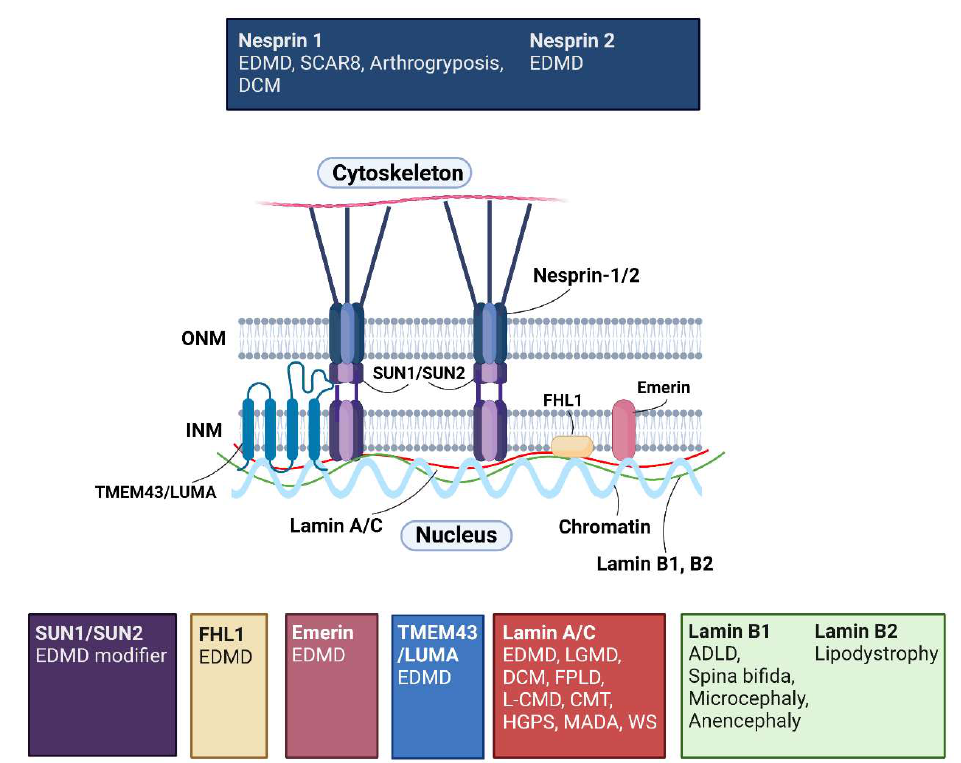
Figure 1. The Linker of Nucleoskeleton and Cytoskeleton (LINC) complex and associated human diseases. The Linker of Nucleoskeleton and Cytoskeleton (LINC) complex primarily consists of SUN1/SUN2 and nesprin proteins, that are located at the inner nuclear membrane (INM) and outer nuclear membrane (ONM), respectively. The respective proteins interact via their Sad1-UNC-84 and Klarsicht/Anc-1/Syne homology (KASH) domains in the lumen of the NE, creating a physical connection between the nuclear lamina (NL) and the cytoskeleton. The NL comprises of type-V intermediate filament proteins, the nuclear lamins. Lamins A/C are A-type nuclear lamins, whilst lamin B1/B2 are B-type lamins. Various other NE proteins interact with the LINC complex including integral INM protein emerin, TMEM43/LUMA and isoforms of four-and-a-half LIM domain protein 1 (FHL1). Mutations in the genes encoding these proteins have been associated with a range of diseases exhibiting different phenotypes. Abbreviations: Emery-Dreifuss muscular dystrophy (EDMD), cerebellar ataxia (SCAR8), dilated cardiomyopathy (DCM), limb-girdle muscular dystrophy (LGMD), familial partial lipodystrophy (FPLD), congenital muscular dystrophy (L-CMD), Charcot-Marie-Tooth disease (CMT), Hutchinson-Gilford progeria syndrome (HGPS), mandibuloacral dysplasia (MADA), atypical Werner syndrome (WS). Created with BioRender.com.